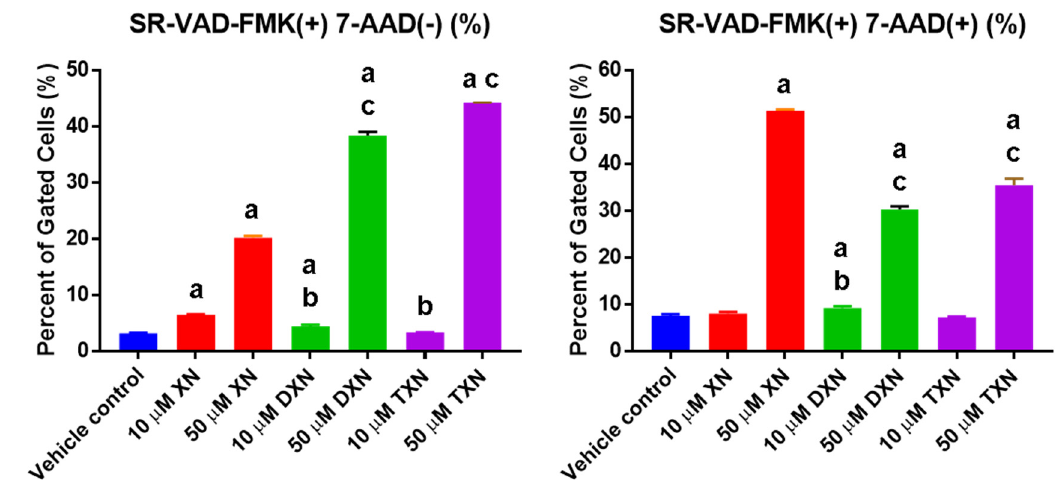
Figure 3. XN, DXN, and TXN induce caspase activation, cellular plasma membrane permeabilization, and cell death in HT29 cells. Cells were treated with each prenylated flavonoid at the concentration indicated (10 or 50 μ M) for 18 h and apoptosis was detected using the multicaspase assay. Apoptosis was detected by flow cytometry after staining with SR ‐ VAD ‐ FMK and 7 ‐ AAD. SR ‐ VAD ‐ FMK ( + ) 7 ‐ AAD( − ) cells are undergoing early ‐ to mid ‐ apoptosis ( left panel ), and SR ‐ VAD ‐ FMK ( + ) 7 ‐ AAD( + ) are undergoing late apoptosis ( right panel ). Values are mean ± SD, n = 9 for each treatment. The letter “a” indicates a statistically significant difference from vehicle control, the letter “b” indicates a statistically significant difference from 10 μ M XN, and the letter “c” indicates a statistically significant difference from 50 μ M XN ( p < 0.05). Statistical analysis was performed using one ‐ way ANOVA with a Sidak’s post hoc test.